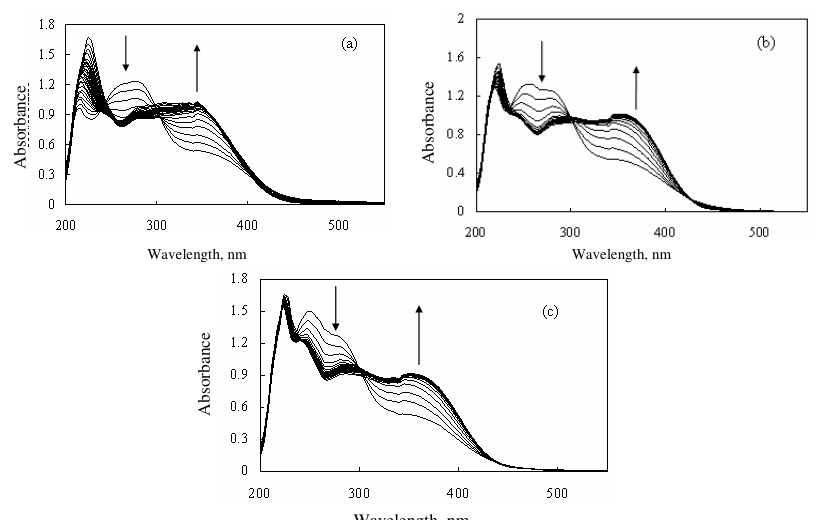
Figure 5. UV-Vis spectra for titration of BHPPDI (3.8 × 10 -5 M) with metal ions containing (1.0 × 10 -3 ) (a) Cu 2+ , (b) Ni 2+ (c) and Co 2+ ion in acetonitrile (25 ˚C and I = 0.05 M